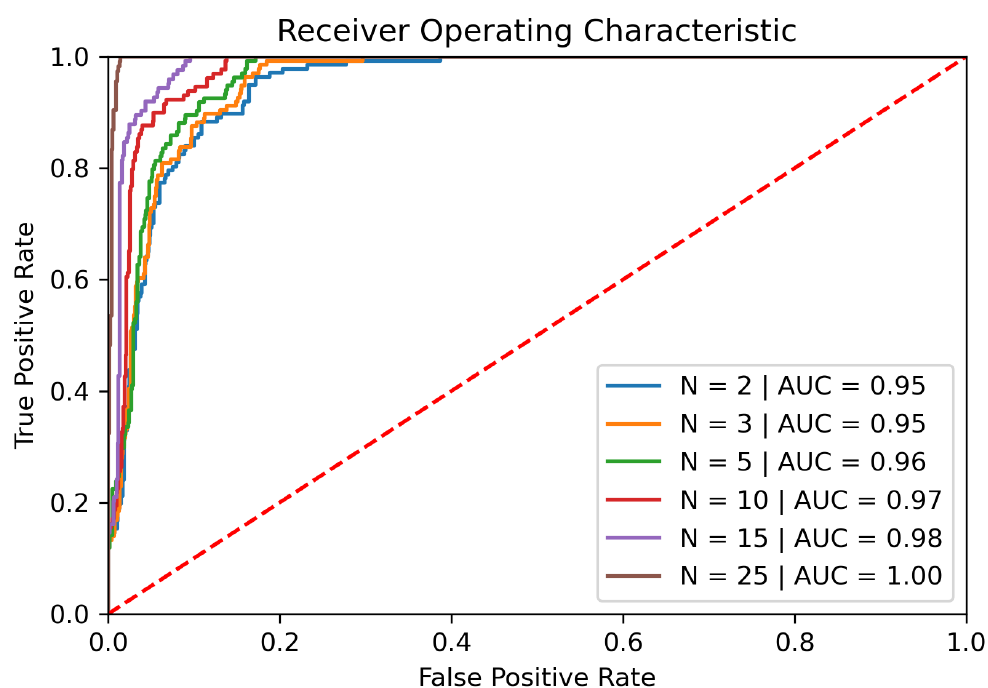
Figure 6. ROC multiple gestures for position and accelerometer data with gesture lengths bigger than 50—6 hidden states and 7